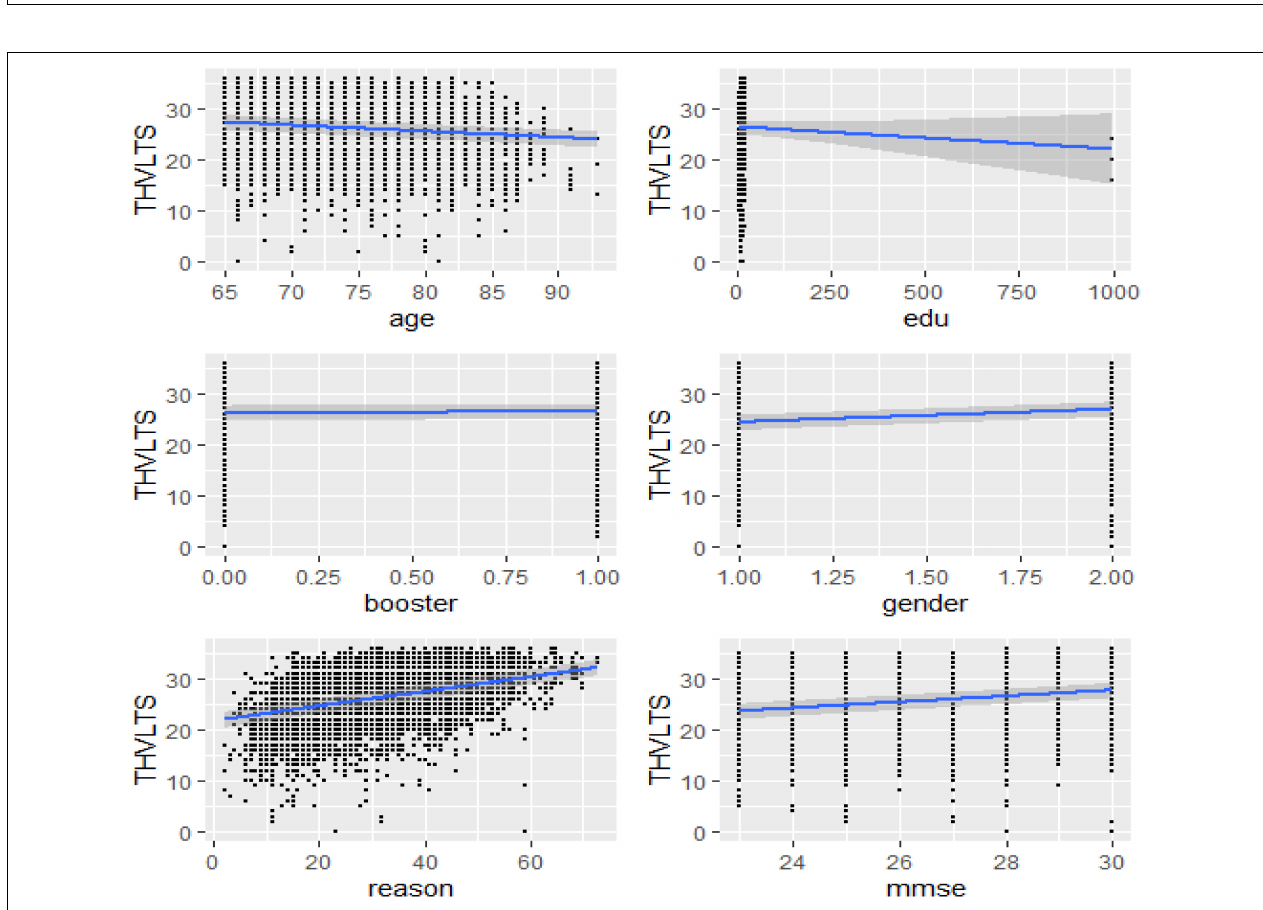
FIGURE 4 | Bayesian hierarchical varying slope fitted model on the observed and predicted outcomes.